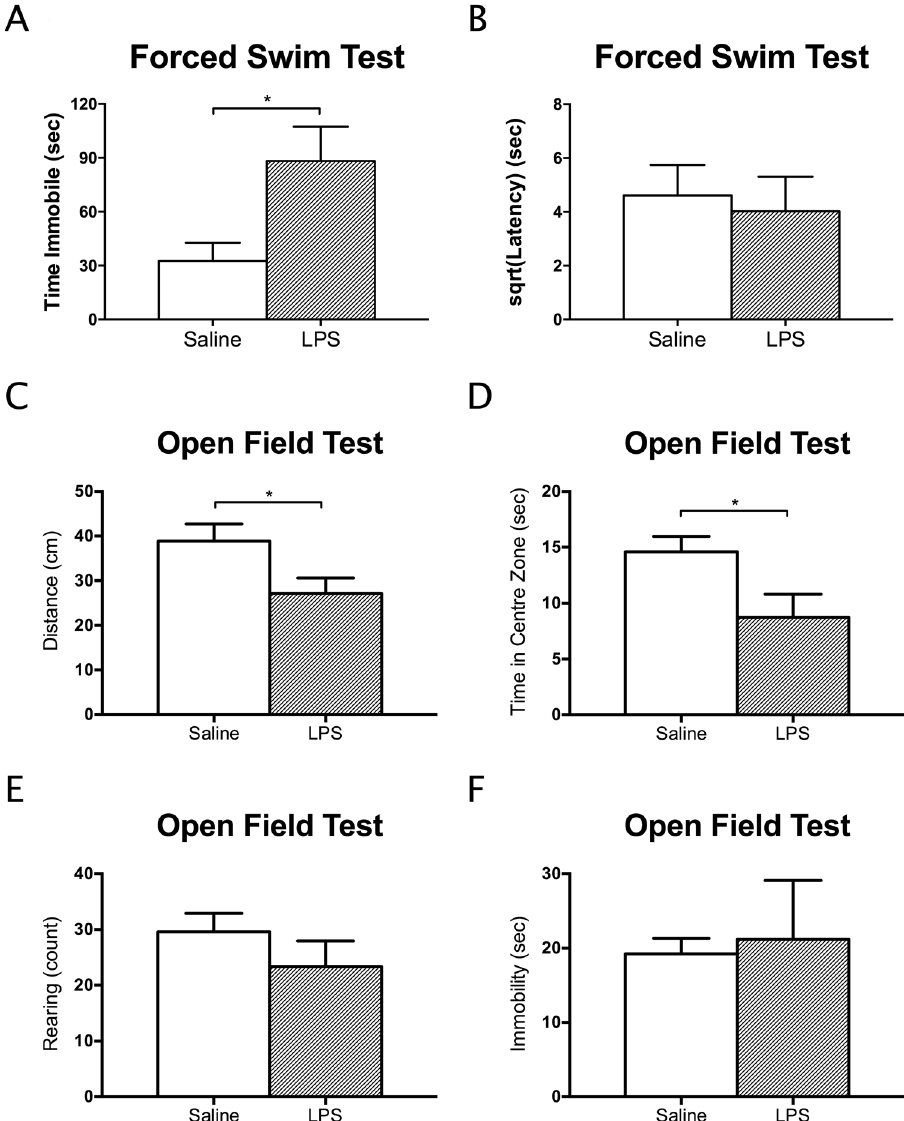
Figure 2. A single injection of LPS increased immobility time in the forced swim test ( A ) relative to mice injected with saline only. Latency to first become immobile was not affected ( B ). In the open field test, both the average distance travelled ( C ) and time in the centre zone ( D ) were reduced, suggesting that the LPS injection was also anxiogenic after 24 h. Rearing ( E ) and immobility time ( F ) in the open field, other measures of locomotor activity, were not altered after 24 h. Data presented as mean + SEM. * p < 0.05; ** p <